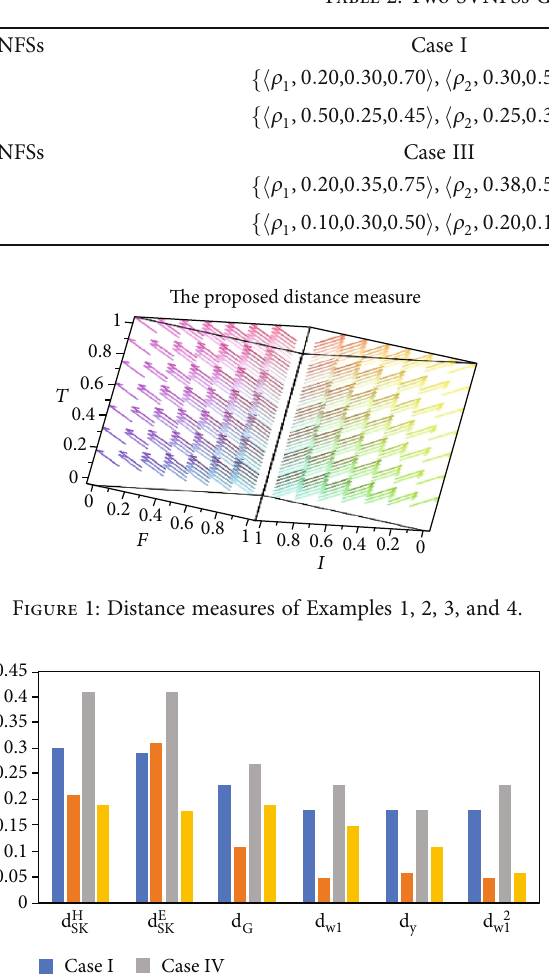
Table 2: Two SVNFSs G